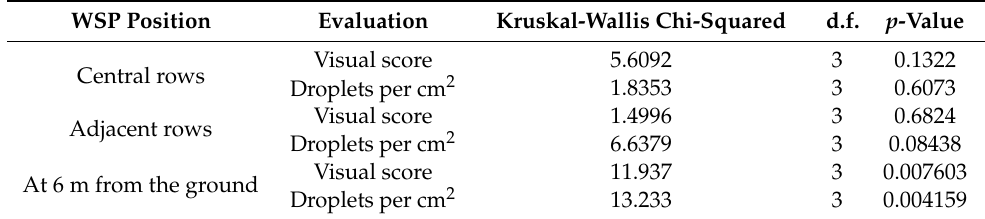
Figure 5. Average values ± standard error of the number of droplets per cm 2 collected on the WSP obtained in ( a ) the central rows and ( b ) the adjacent rows by the four sprayer configurations. Table 2. Kruskal–Wallis chi-squared statistics and P-values for the position of the samples, year, and method of quality application evaluation of the